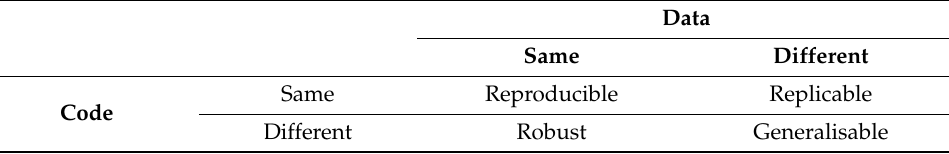
Table 2. Whitaker’s definitions of R-Terms [16] (table adapted from [17]). Data Same Different Same Reproducible Replicable Code Different Robust